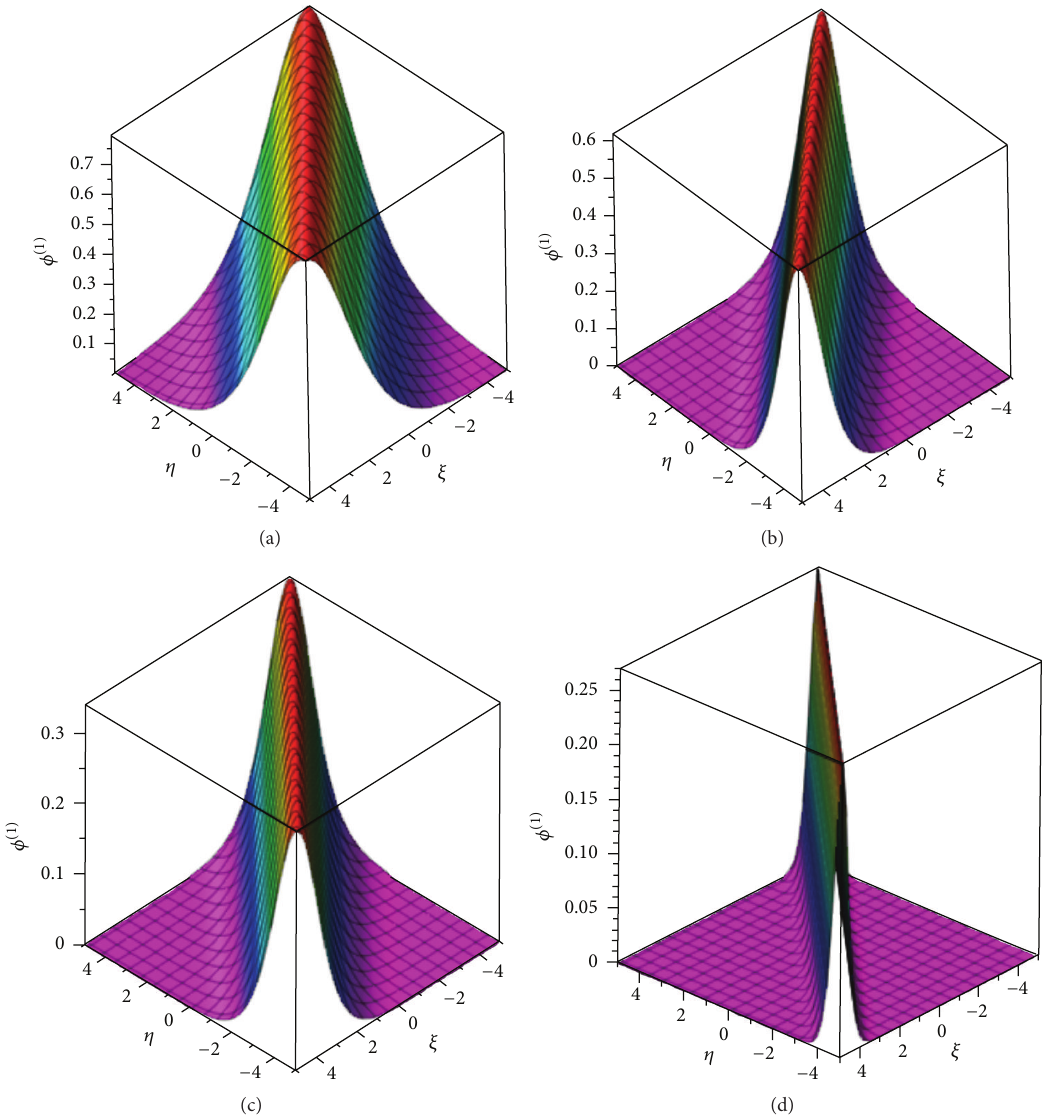
Figure 6: Initial potential profiles 𝜙 (1) of the IA solitary waves for (a) 𝛼 = 0.1 , 𝑞 = 0.6 , 𝛽 = 0.1 , 𝜎 = 1 , 𝛿 = 0.01 , and 𝑉 = 0.75 ; (b) 𝛼 = 0.4 and the remaining parameters as in (a); (c) 𝛿 = 0.1 and the remaining parameters as in (b); and (d) 𝜎 = 10 and the remaining parameters as in